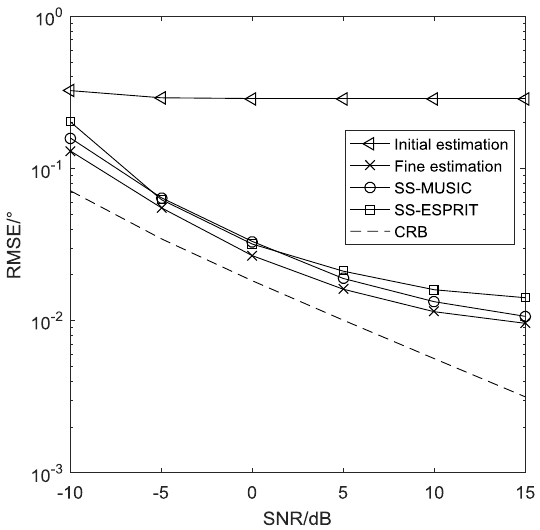
Figure 5. RMSE comparison of different methods.